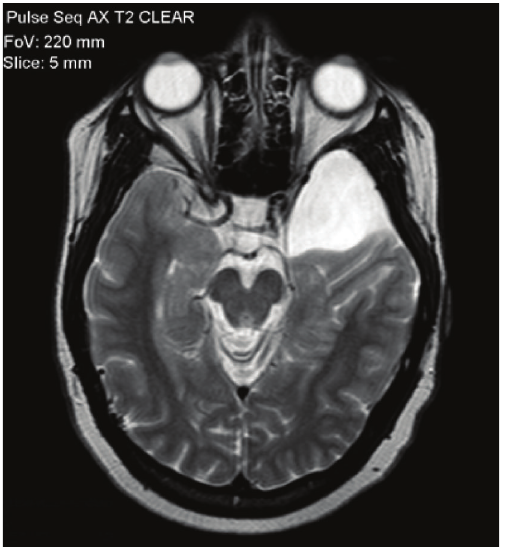
Figure 2: Cranial MRI without contrast in the horizontal plane, demonstrating the mass effect on the left temporal lobe by the arach- noid